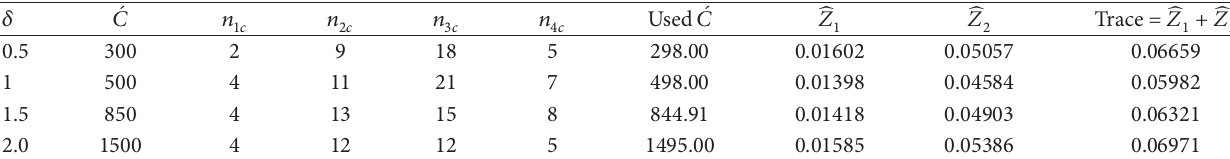
Table 5: Khan et al. compromise allocation.